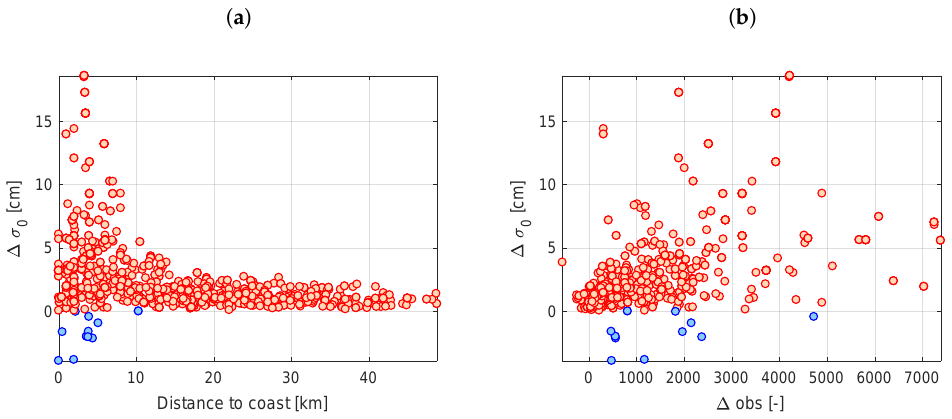
Figure 3. Difference in the number of observations between ALES and SGDR at each node against the distance to coast. The blue dots show the cases for which less observations are available for ALES, while the red dots correspond to a larger amount of data for ALES.